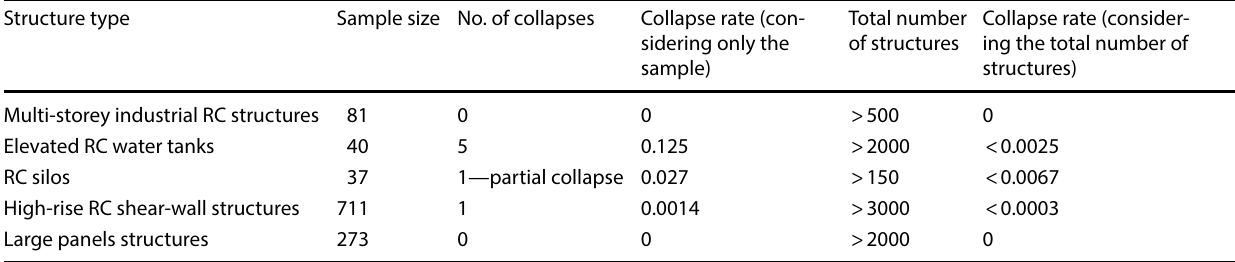
Large panels structures